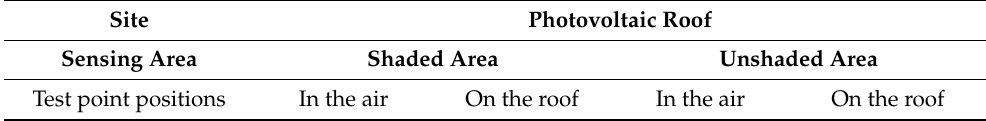
Table 1. Sensing positions on the photovoltaic roof. Site Photovoltaic Roof Sensing Area Shaded Area Unshaded Area Test point positions In the air On the roof In the air On the